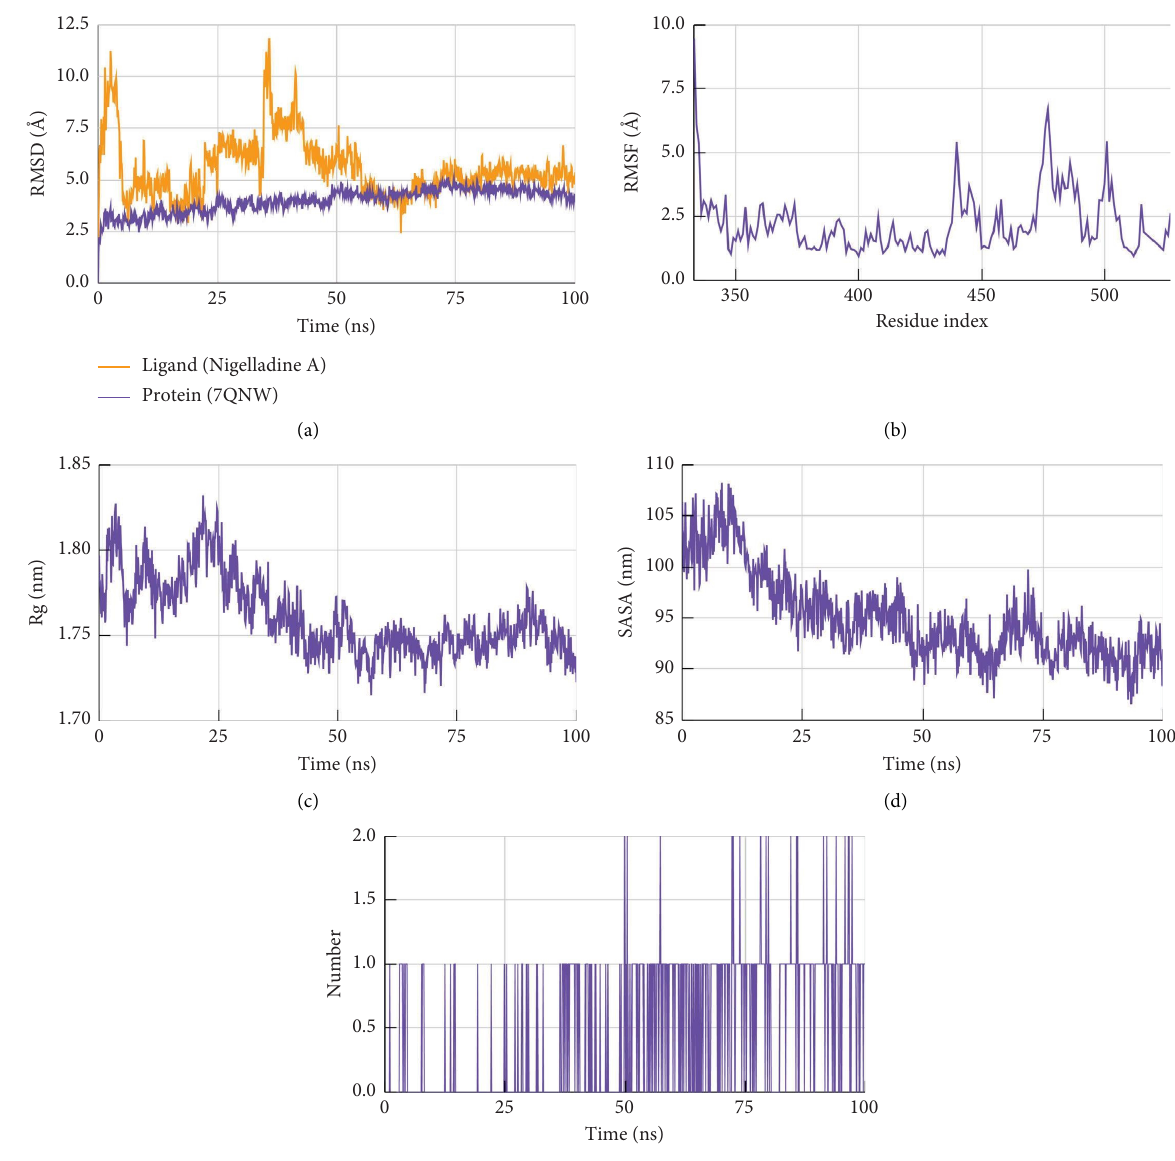
Figure 4: Te (a) root mean square deviations (RMSD), (b) root mean square fuctuations (RMSF), (c) radius of gyration (Rg), (d) solvent accessible surface area (SASA), and (e) number of hydrogen bonds (h-bonds) plots for the protein-ligand complex of Nigelladine A and spike protein generated during MD